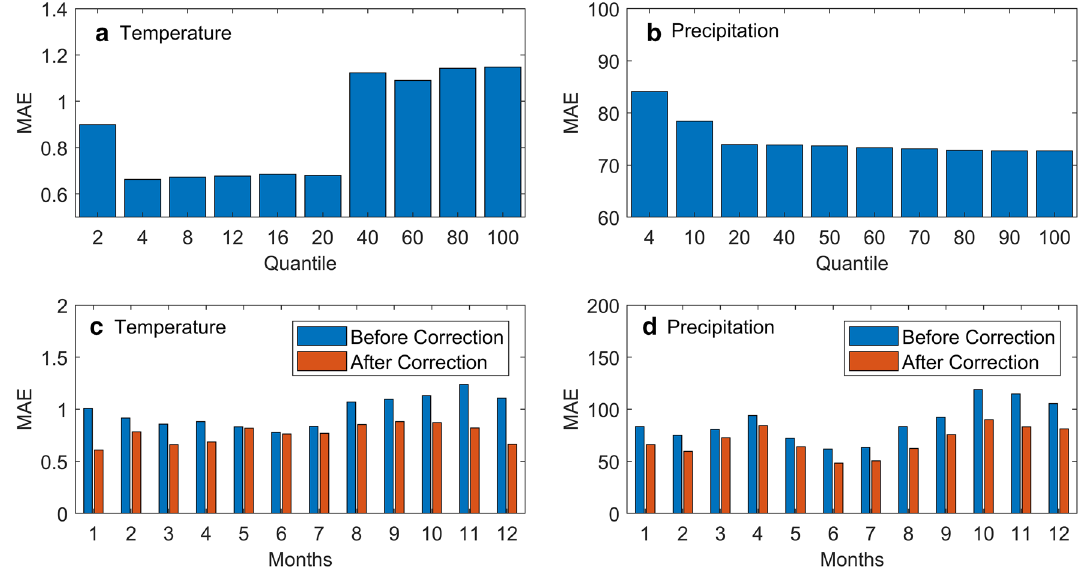
Figure 2. ( a ). The results of the validation of the temperature quantile value with n = 4, ( b ). The results of the validation of the rainfall quantile value with n = 80 and ( c ). Validation results for the temperature model and ( d ) for the rainfall model.